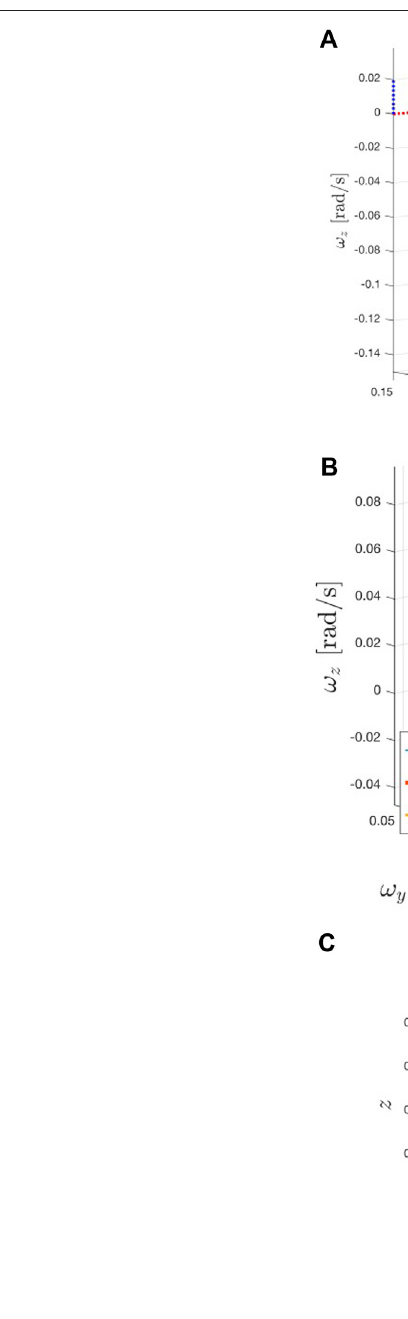
FIGURE 8 | (A) ResultingpolhodeafteralignmenttotheTarget ’ sestimatedprincipalaxes.Thepolhode ’ splaneprojectionsproducecentralconics(notrotatednordisplaced from their respective origins). Solid circles indicate the polhode, and open circles indicate the projected conics. (B) Polhode comparison between the measured (blue, in geometric frame),aligned(red,afterrotatingbytheestimatedorientationfromgeometrictoprincipalaxes),andgroundtruth-aligned(orange)curves. (C) Visualcomparisonoftheoffsetbetween the groundtruth principal axes (bold RGB triad) against the estimated orientation (thin, longer RGB triad).